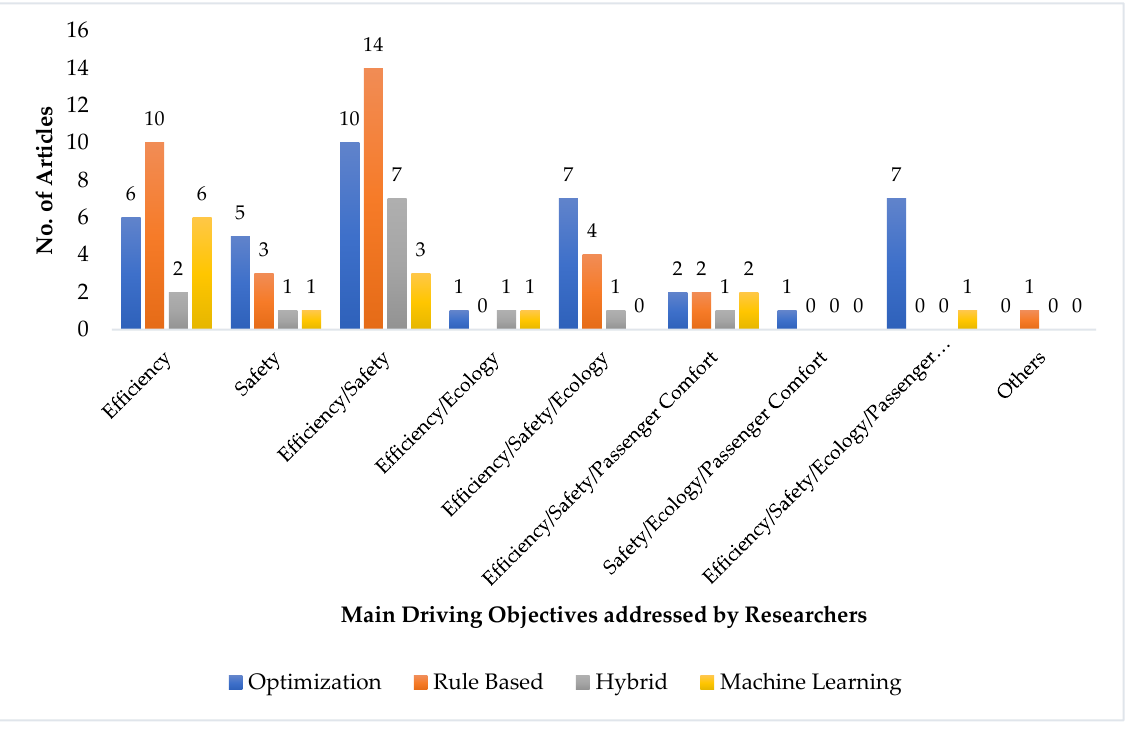
Figure 7. Article distribution depending on techniques and driving